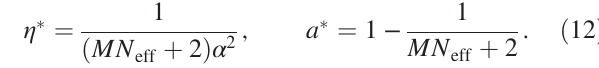
FIG. 2. Hypothetical rotation of inputs and weight diffusion. (a) Because the inputs (left, black) are summed linearly, they can be “ rotated ” so that for our tasks the first N inputs are nonzero and agree with the latent inputs (middle, black). The remaining inputs are eff then zero (middle, red), and their weights are irrelevant for the output (right, red). (b)(i) In WP with finite perturbation size σ irrelevant weights diffuse without bounds (red), while the relevant weights converge and fluctuate (black) around the teacher weights. Displayed are the mean (solid) and standard deviation (shaded area) of the weight ensembles. (b)(ii) Weight decay or (b)(iii) input noise 2 , the latent inputs are a sine and a cosine. Parameters in (b)(i) and (b)(ii): M ¼ 10 , N; T ¼ 100 , confines the diffusion. In (a), N eff ¼ 50 , σ 0 . 04 , teacher weights w 0 . 1 , and weight decay γ 0 . 999 ; results are averaged over ten runs. (b)(iii) The same N eff ¼ eff ¼ rel ;i ¼ WD ¼ parameters, except η ¼ 0 . 2 η (cid:2) and added iid white input noise with strength σ 2 ¼ 0 . 5 (SNR ¼ 2 noise